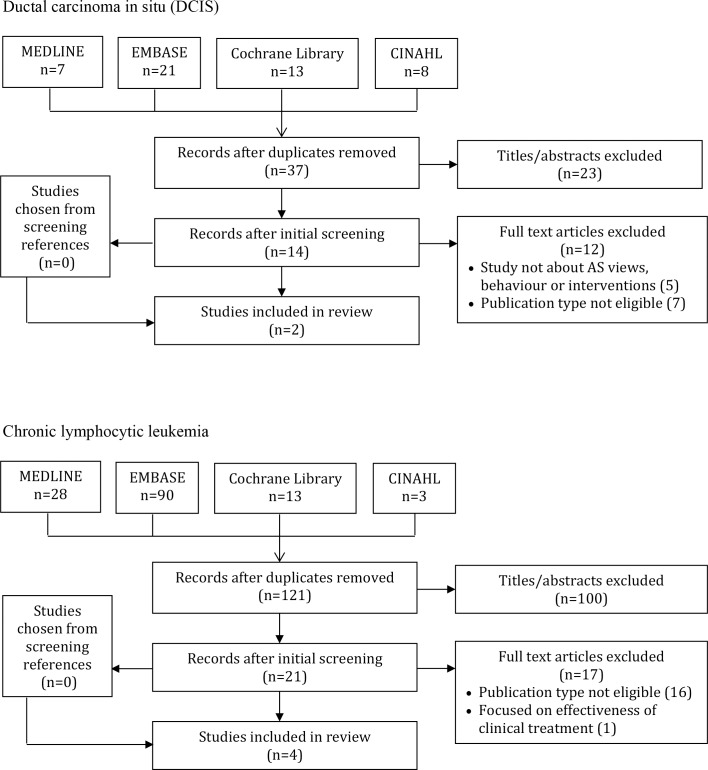
PRISMA diagrams.